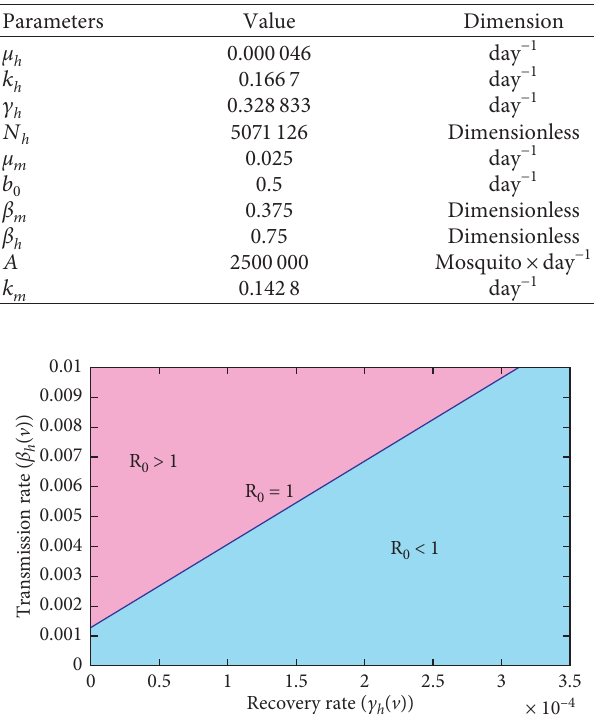
� 1. The red colored region defines endemic 0